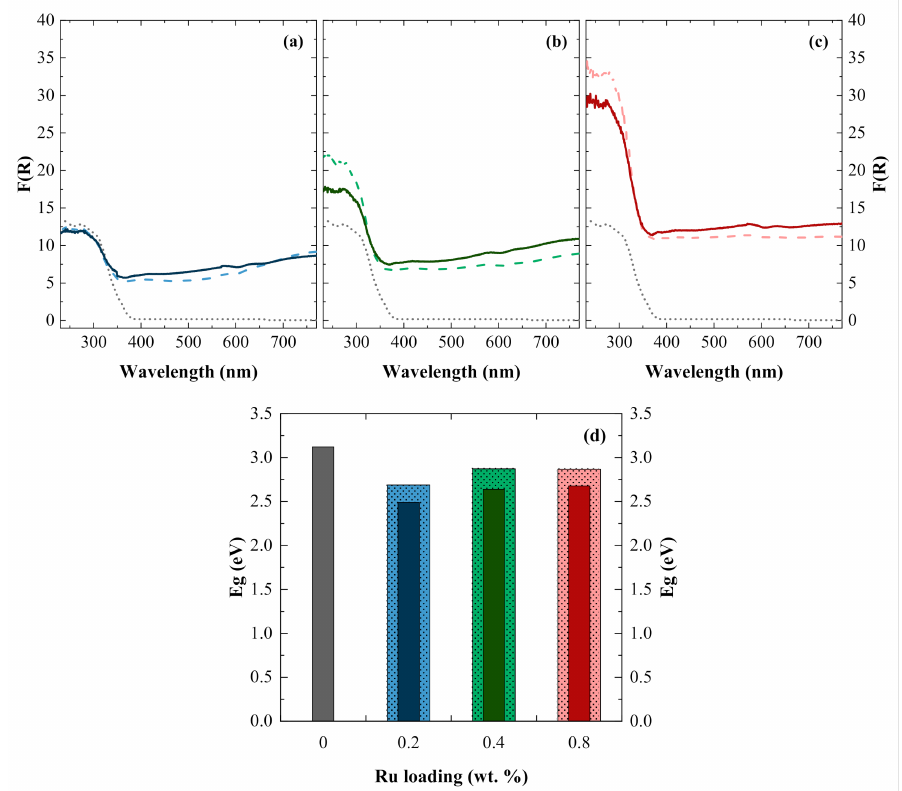
Figure 2. ( a – c ) UV-Vis diffuse reflectance spectra, represented as a Kubelka-Munk function of the reflectance—F(R), and ( d ) optical band gap energy (Eg) for undoped SrTiO 3 (dotted lines, darker solid bar), Ru-doped SrTiO 3 (dashed lines, patterned bars) and Ru and Ni co-doped SrTiO 3 (solid lines, colored solid bars) photocatalysts, using Ru concentrations of ( a ) 0.2 wt. %, ( b ) 0.4 wt. %, and ( c ) 0.8 wt. % and a [Ru]:[Ni] molar ratio of